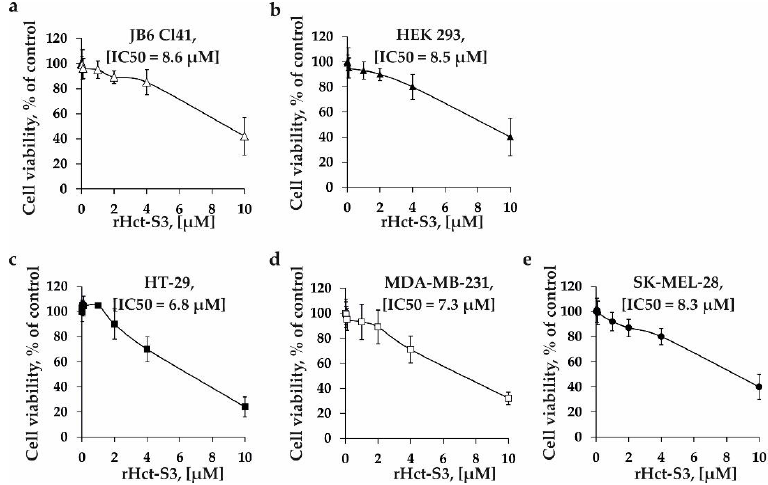
Figure 2. The e ff ect of rHct-S3 on cell viability of ( a ) normal mouse epidermal cells JB6 Cl41, human ( b ) embryonic kidney HEK 293, ( c ) colorectal carcinoma HT-29, ( d ) breast cancer MDA-MB-231, and ( e